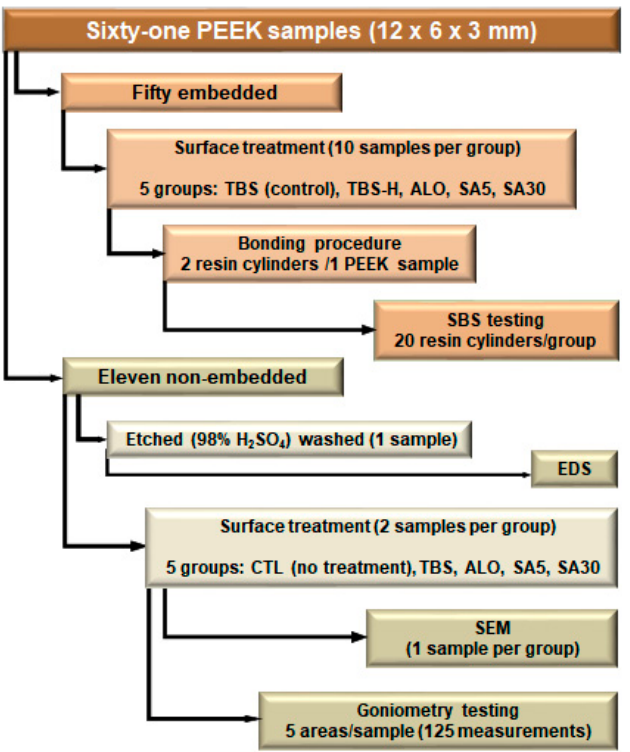
Figure 1. Schematic representation of the distribution of embedded/non-embedded PEEK samples in different groups according to its final destination: Shear bond strength (SBS) testing, goniometry, micromorphological analysis (SEM) or spectroscopy (EDS).